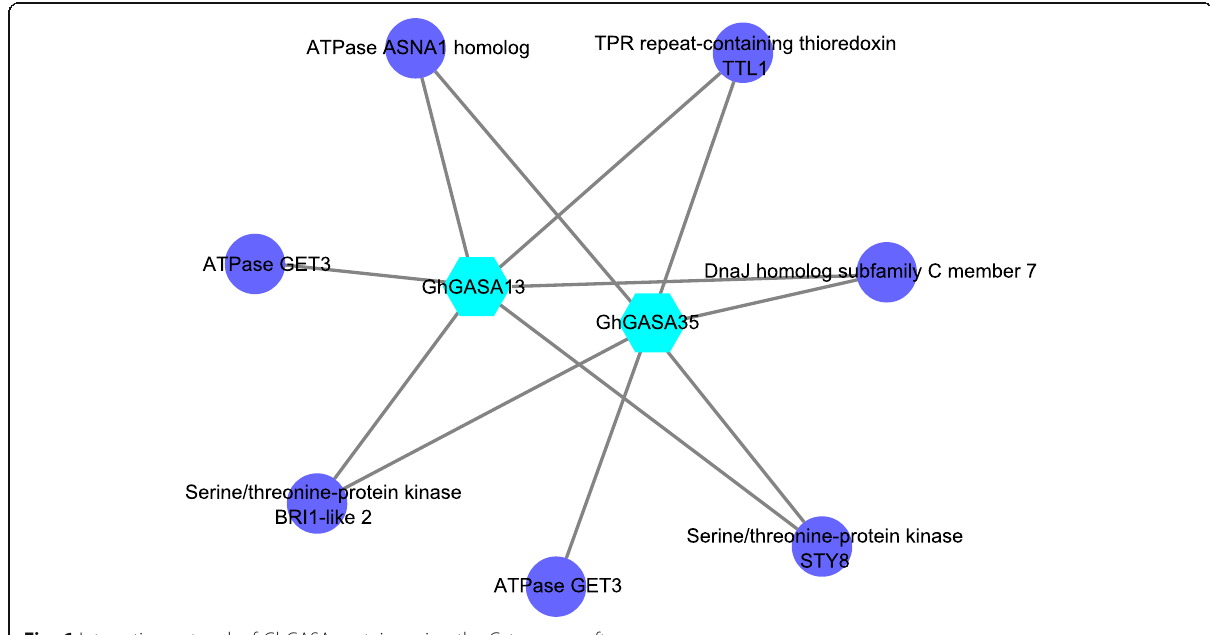
Fig. 6 Interaction network of GhGASA proteins using the Cytoscape